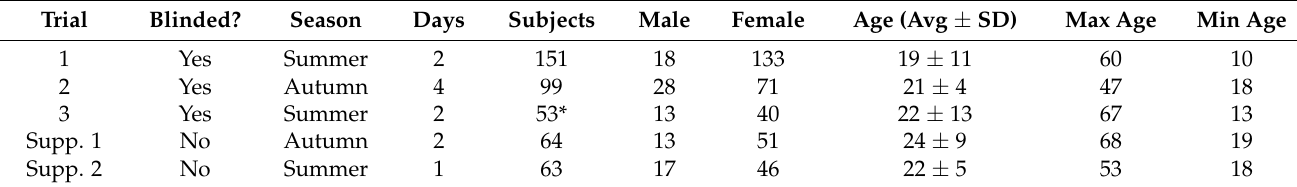
Table 4. Summary of experiment trial parameters and